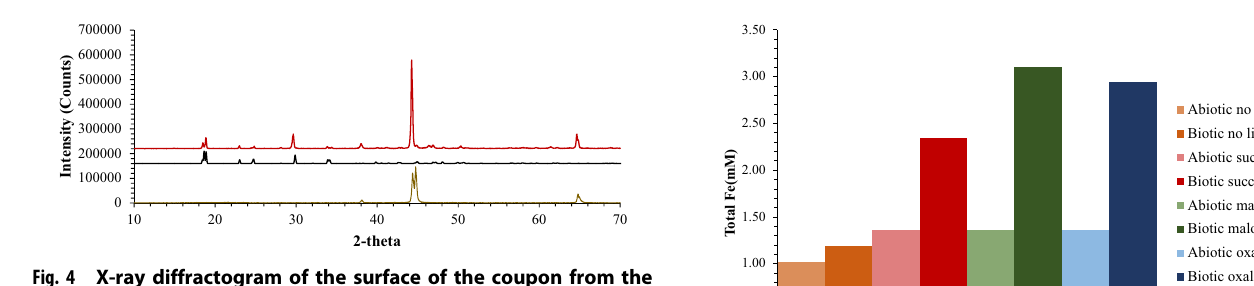
Fig. 3 SEM micrographs of the surface of oxidized carbon steel coupons after 26 h of experimentation with S . oneidensis MR-1 and dicarboxylates. a 50 mM oxalate, b 50 mM malonate, c 50 mM succinate, and d no ligand. Panel e and f show the SEM micrograph of an oxidized carbon steel coupon before experimentation and its corresponding EDS spectrum.